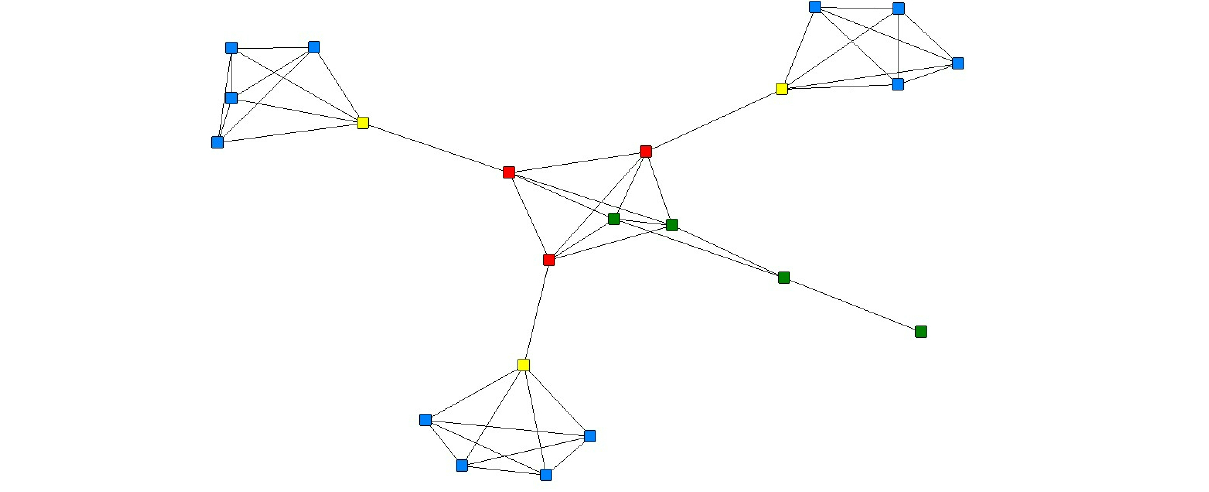
Figure 3. Sociogram of the traditional network where the relational tie is